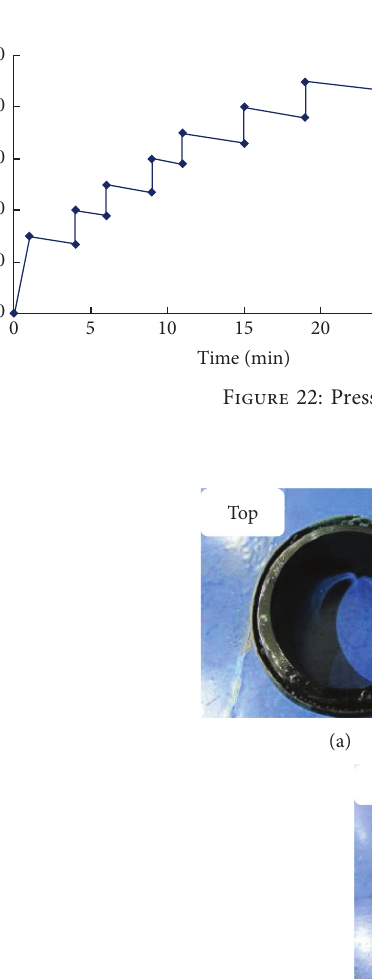
Figure 21: Experimental device of pressure-bearing and physical drawing of rubber sleeve.